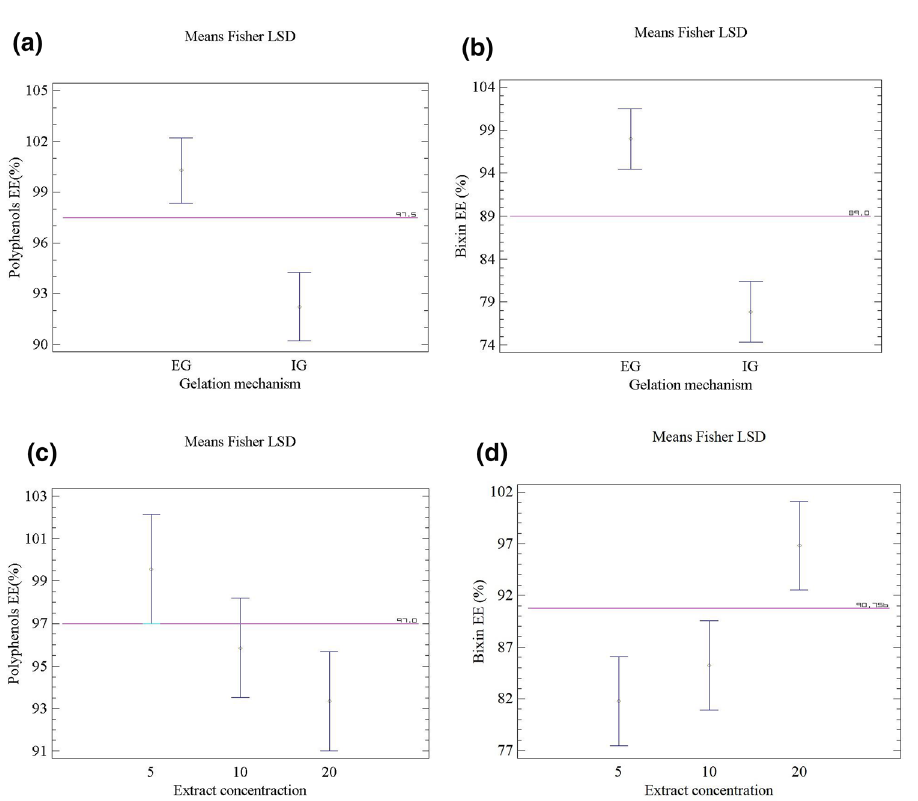
Figure 2. Fisher’s LSD test with 95% confidence for: ( a ) EE for polyphenols compounds with respect to gelation type; ( b ) EE for bixin with respect to gelation type; ( c ) EE for polyphenol compounds with respect to the extract concentration; ( d ) EE of bixin with respect to the extract